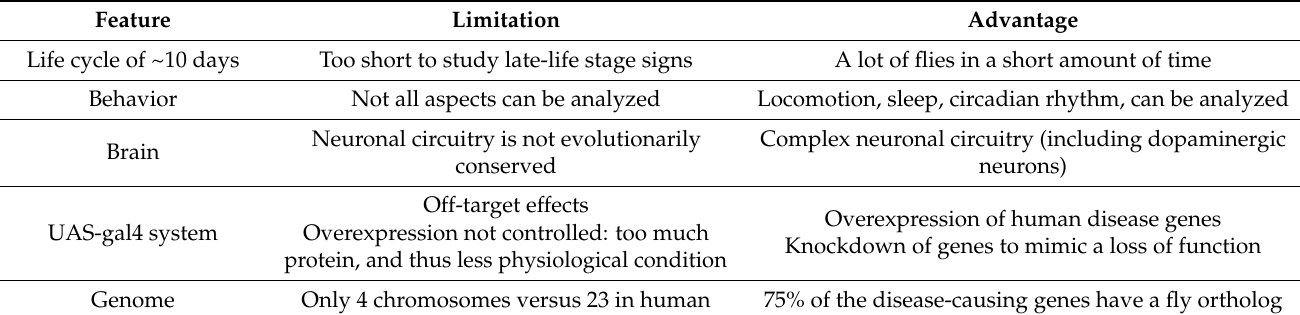
Table 1. Limitations and advantages of different aspects of using D. melanogaster as animal model to study human diseases.